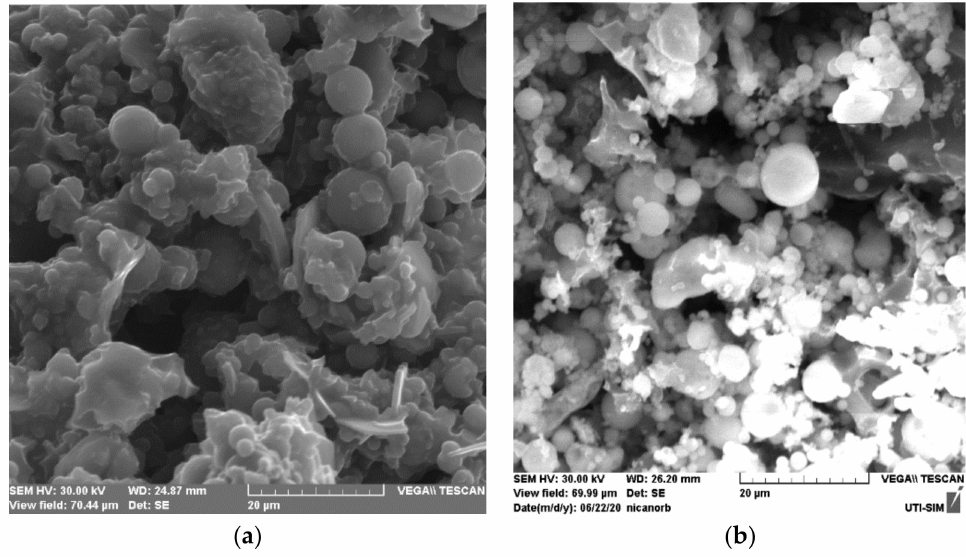
Figure 1. SEM images for FA / H 2 SO 4 ( a ) and FA / H 2 SO 4 + Cd 2 + ( b ), at a resolution of 20 µ m.